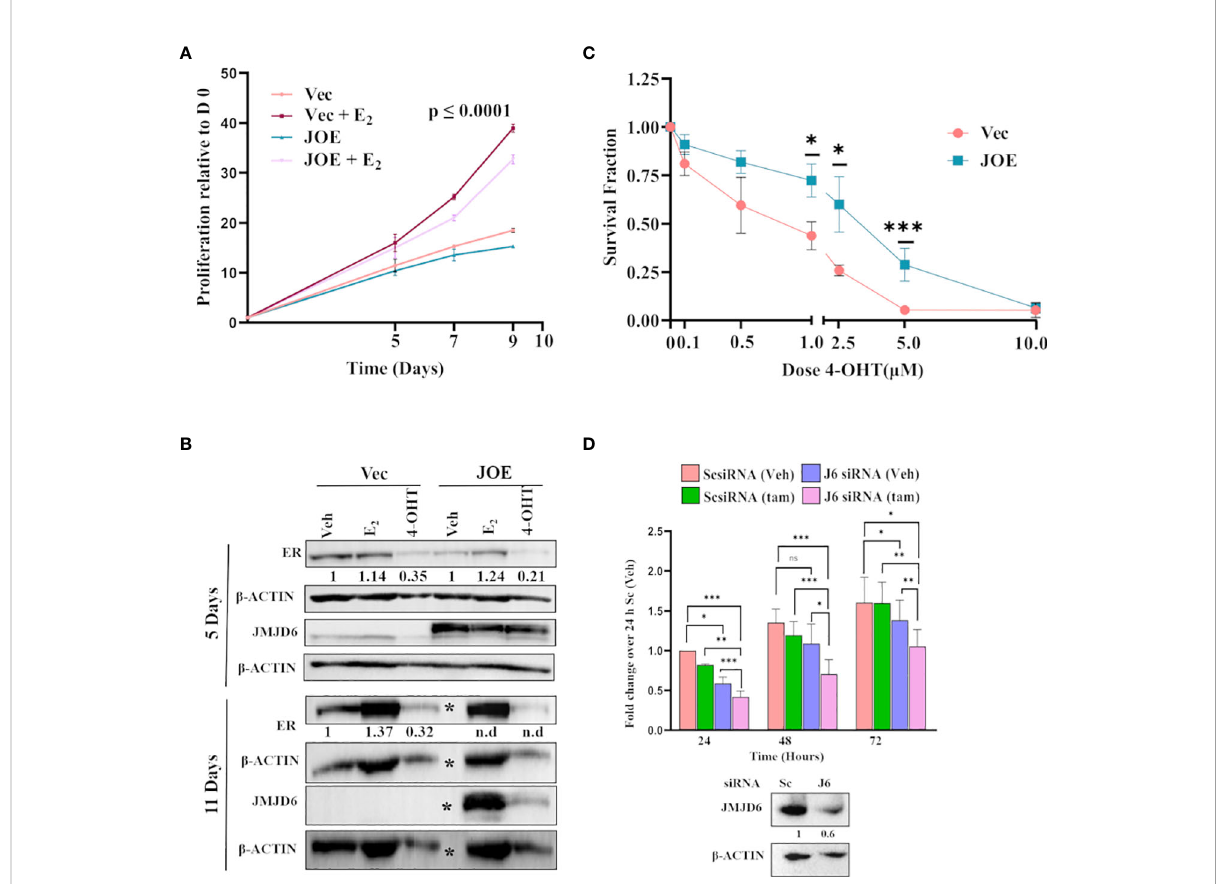
FIGURE 7 Effect of E 2 and 4-OHT in JOE cells. (A) Cell proliferation assay in the presence of estrogen. Untreated Vec and JOE cells, and Vec cells treated with the hormone were used for comparison. (B) Western blot of E 2 and Tam treated Vec and JOE cells after 5 and 11 days of E 2 treatment. ‘ * ” denotes vehicle treated JOE cells that do not survive more than 10 days in E 2 deprived media, therefore, no protein is available on day 11. Numbers below immunoblot panels represent densitometric scanning data plotted as a mean of three independent experiments (n.d.- not determined) in Vec cells, ER levels after E 2/ Tam were normalized to ER levels from ‘ Veh ’ treated Vec cells; In JOE cells, they were normalized to ER levels from ‘ Veh ’ treated JOE cells (C) Cell viability assay for MCF7 and JOE cells in the presence of different doses of 4-OHT. (D) JMJD6 siRNA and Tam treatment of TAM R cells. Upper panel: Data from ScsiRNA transfected cells treated with Veh for 24 h was normalized to 1 and data for J6siRNA and Tam treatment at different time points are expressed as fold change over 1. Lower panel: Immunoblot showing depletion of JMJD6 following siRNA treatment. Numbers indicate means of densitometric scanning